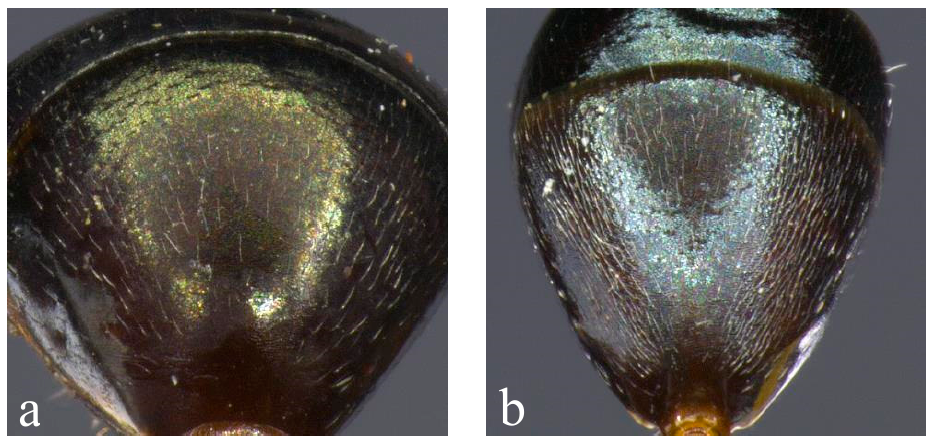
Figure 7. Variation in gastric pubescence. First gastric segments of minor workers of ( a ) Taxon 1A (BOLD ID: MELPS087-17) and ( b ) Taxon 1C (BOLD ID: DARW621-16) from the sp. 1 complex.